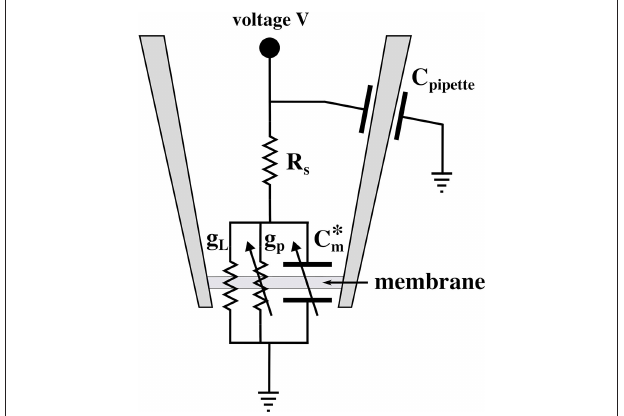
FIGURE 2 | Equivalent circuit diagram of the patch experiment. Here, C * m is the effective voltage-dependent capacitance of the membrane (see text), g p is the voltage-dependent conductance of the lipid pores, g L is the constant leak conductance, R S is a series resistance of the pipette interior, C pipette is the capacitance of the pipette, and V is the externally applied voltage.